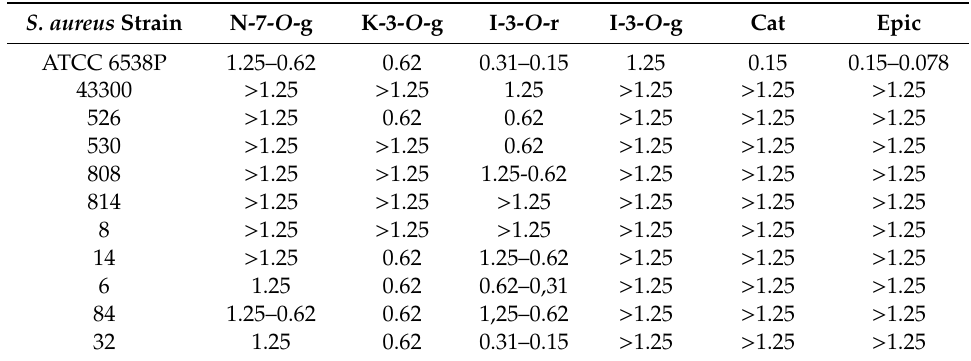
Table 2. Minimal inhibitory concentrations of almond skin flavonoids (expressed as mg / mL) against S. aureus ATCC and clinical